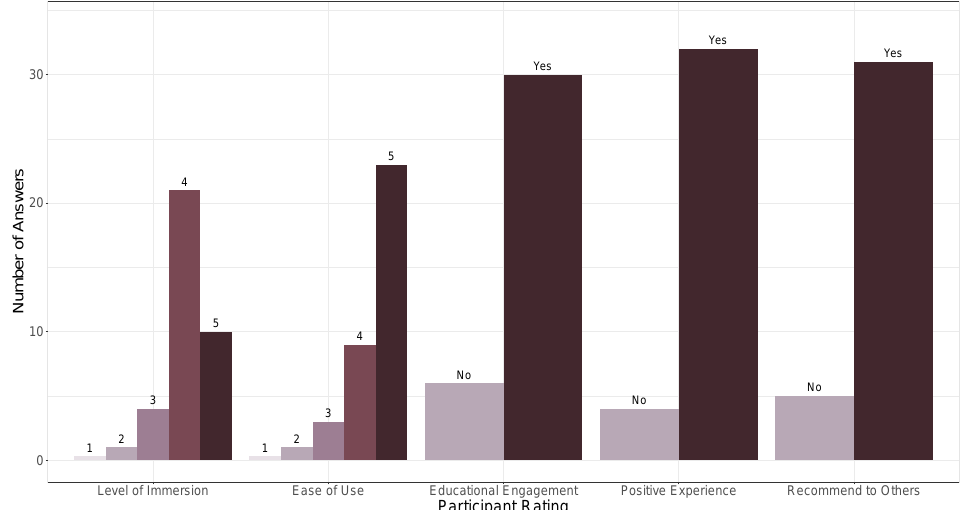
Figure 12. Results of questionnaire-based subjective feedback from 36 high school student participants on the virtual environment application, including ratings on level of immersion, ease of use, level of engagement with the educational content, overall satisfaction, and recommendation to